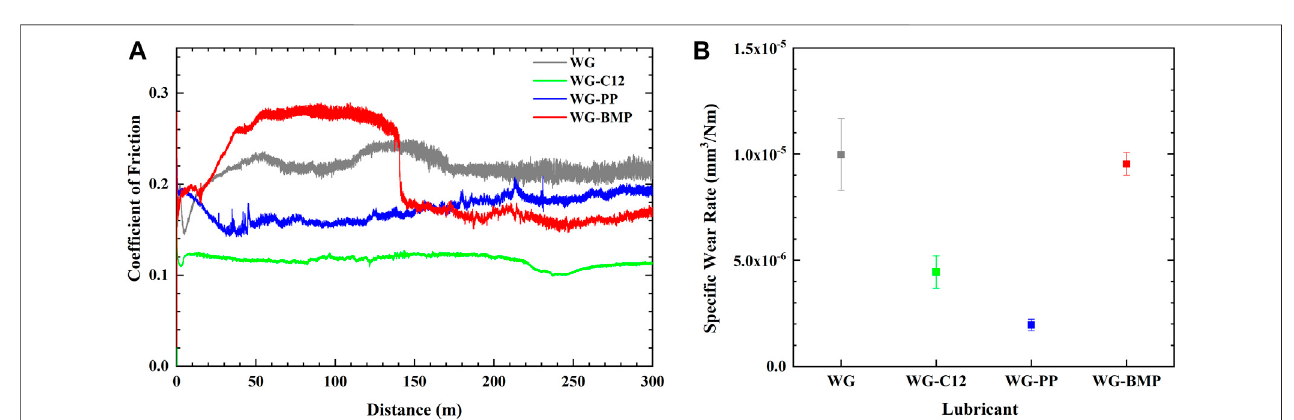
FIGURE1| Friction evolution (A) and speci fi cwear rate (B) ofAISI 52100 steel tested with different additives in water-glycol at room temperature. Only one friction evolution graph is shown for each test due to the good repeatability of the results.